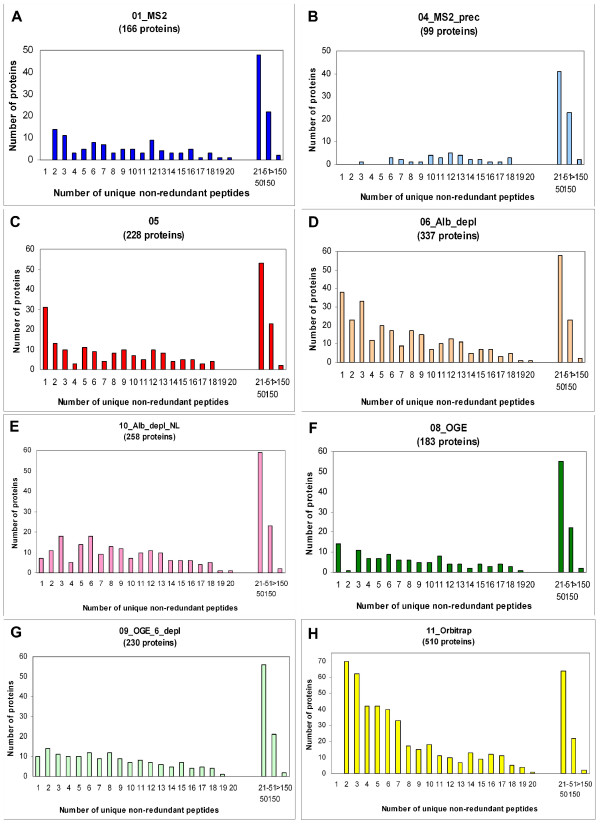
Histograms showing the number of proteins identified with a given number of unique peptides for each individual experiment. The number of validated, non-redundant peptides was calculated for each protein identified within the context of each individual experiment, and proteins having identical numbers of peptides were grouped together and plotted as indicated. The Y-axes (number of proteins) for the experiments indicated in panels C and D and in A, B, E, F and G have been standardized in order to facilitate cross-experiment comparison.